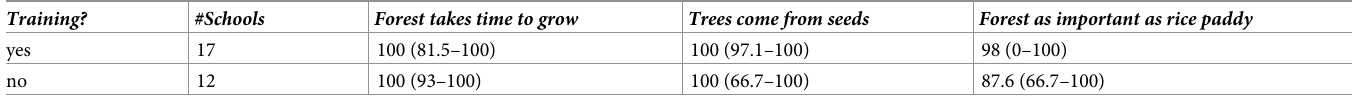
Table 2. Responses from students when schools are classified by training status.